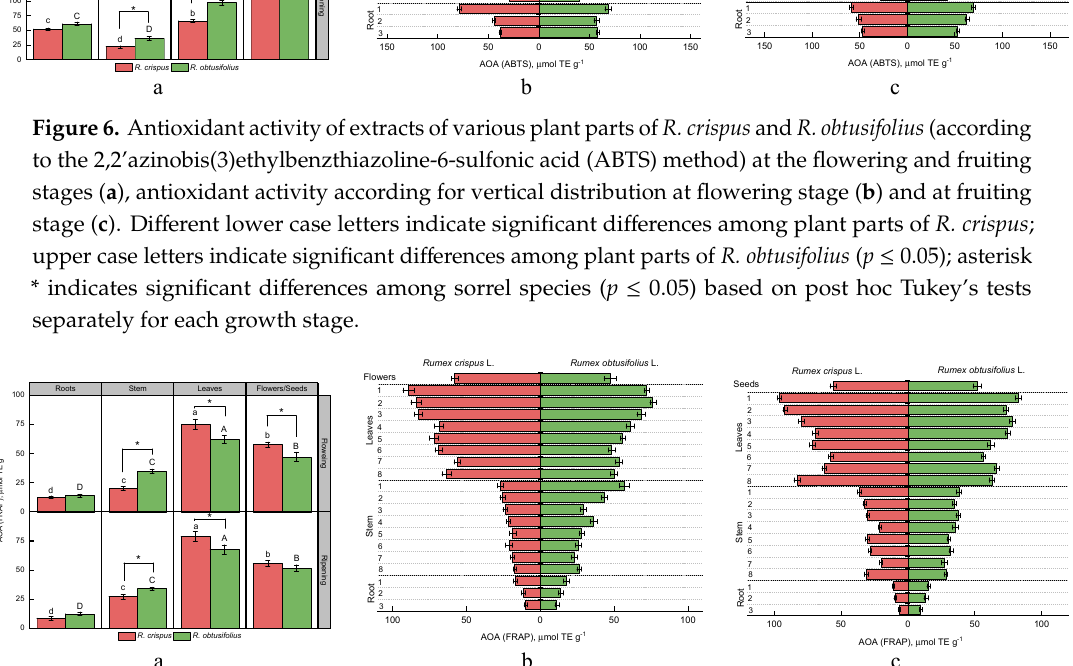
Figure 7. Antioxidant activity of extracts of various plant parts of R. crispus and R. obtusifolius (according to the ferric reducing antioxidant power (FRAP) method) at the flowering and fruiting stages ( a ), antioxidant activity according for vertical distribution at flowering stage ( b ) and at fruiting stage ( c ). Different lower case letters indicate significant differences among plant parts of R. crispus ; upper case letters indicate significant differences among plant parts of R. obtusifolius ( p ≤ 0.05); asterisk * indicates significant differences among sorrel species ( p ≤ 0.05) based on post hoc Tukey’s tests separately for each growth stage.